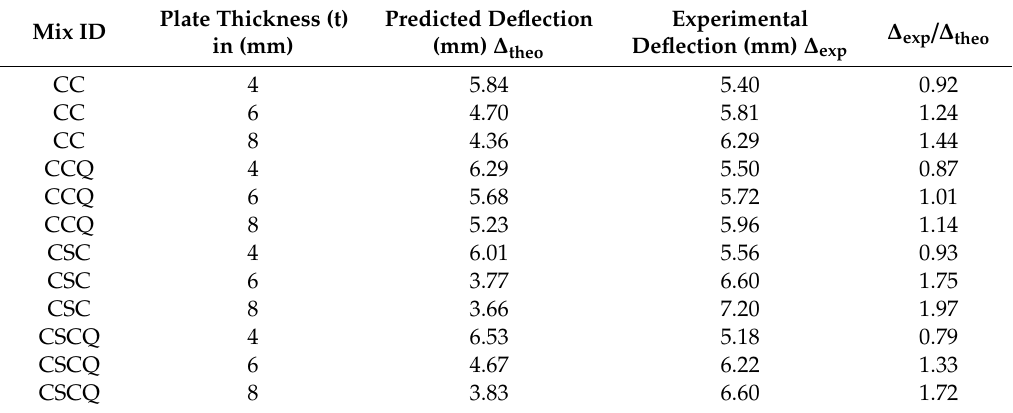
Figure 18. Moment–deflection curve for SCS beams used with CSCQ mix. Table 5. Comparison of experimental and predicted deflection of